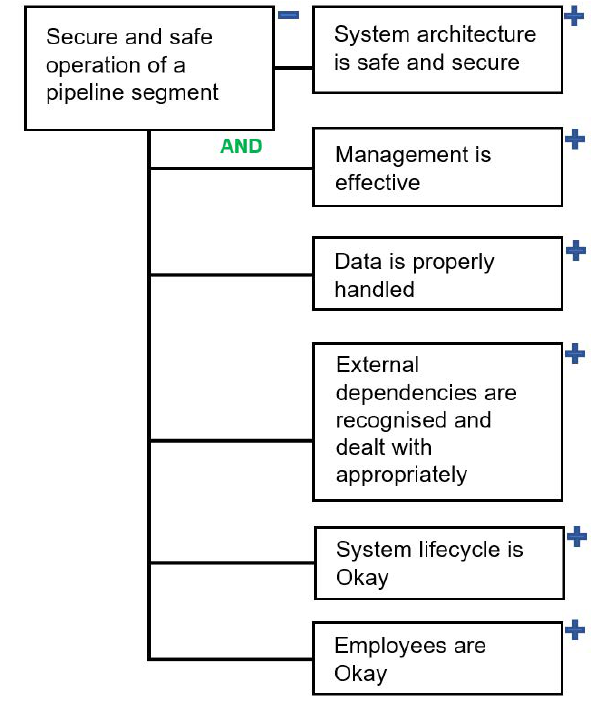
Figure 3. The Top Level of the SCADA